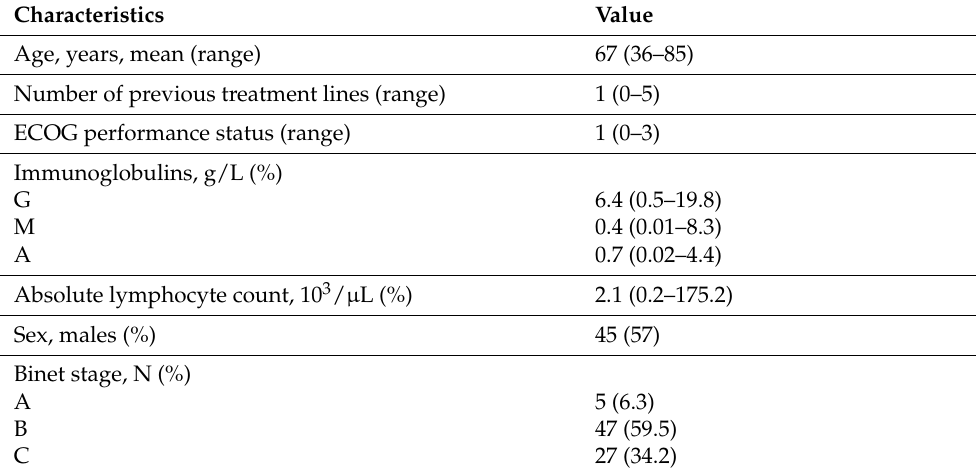
Table 1. Patient